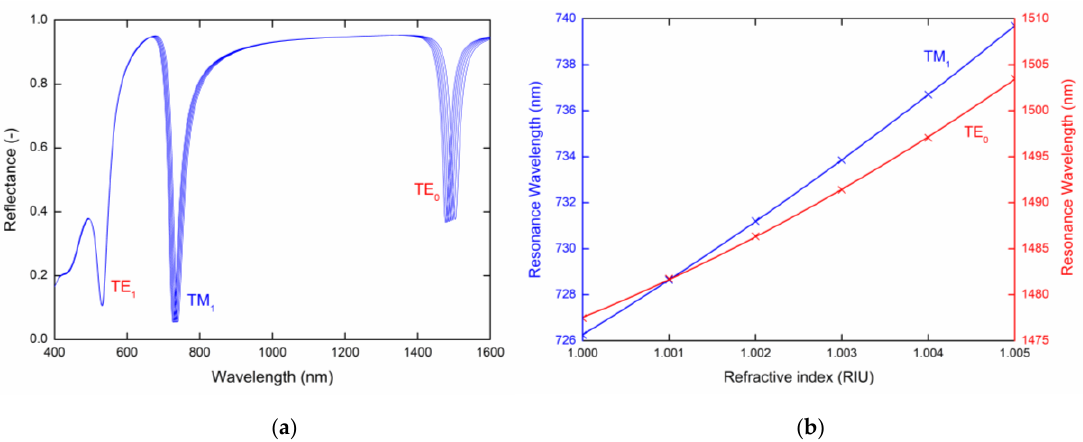
Figure 5. Theoretical spectral reflectances R 45 ( λ ) ( a ) and resonance wavelength as a function of the refractive index of the external medium ( b ).